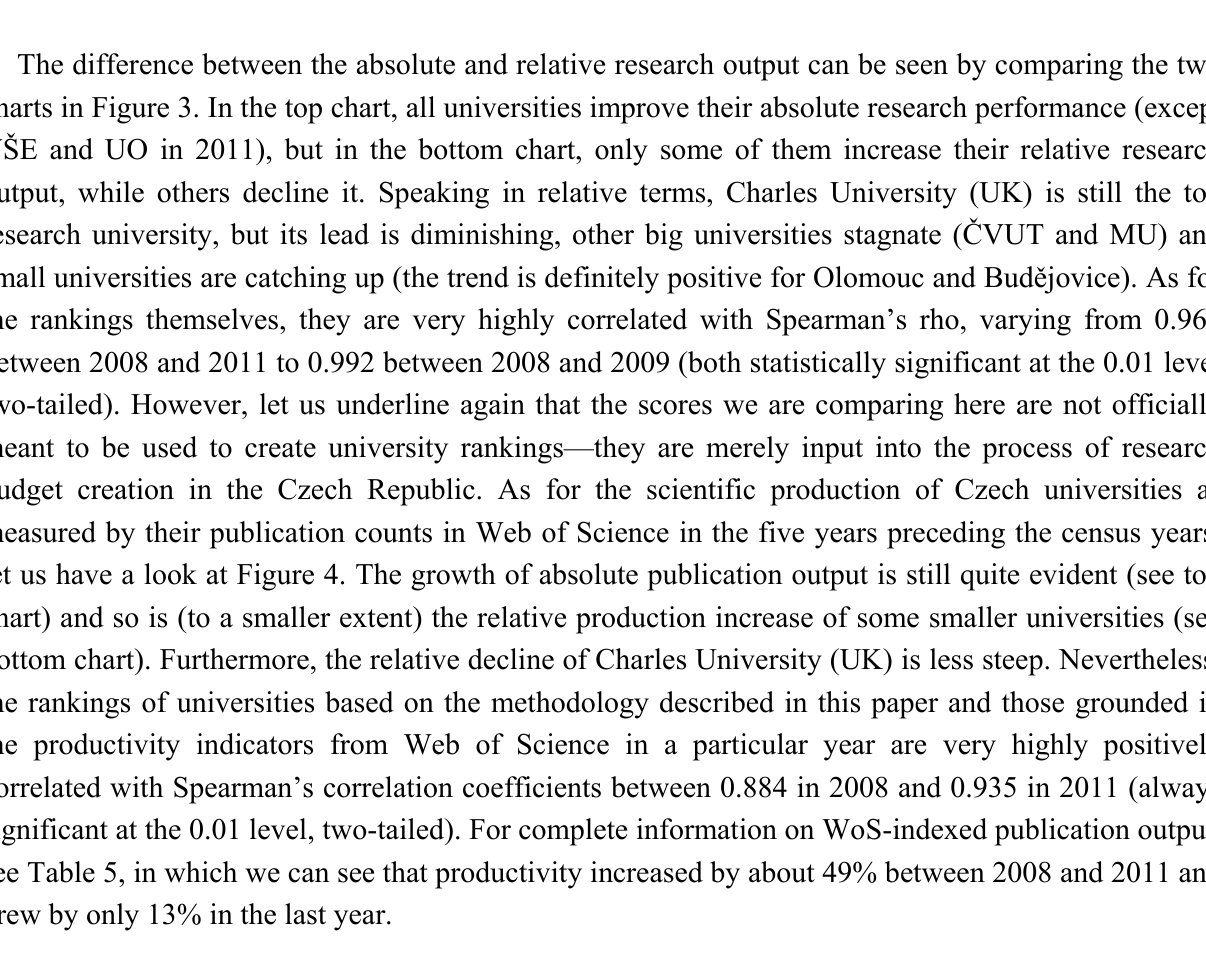
Figure 3. Absolute and relative university scores in